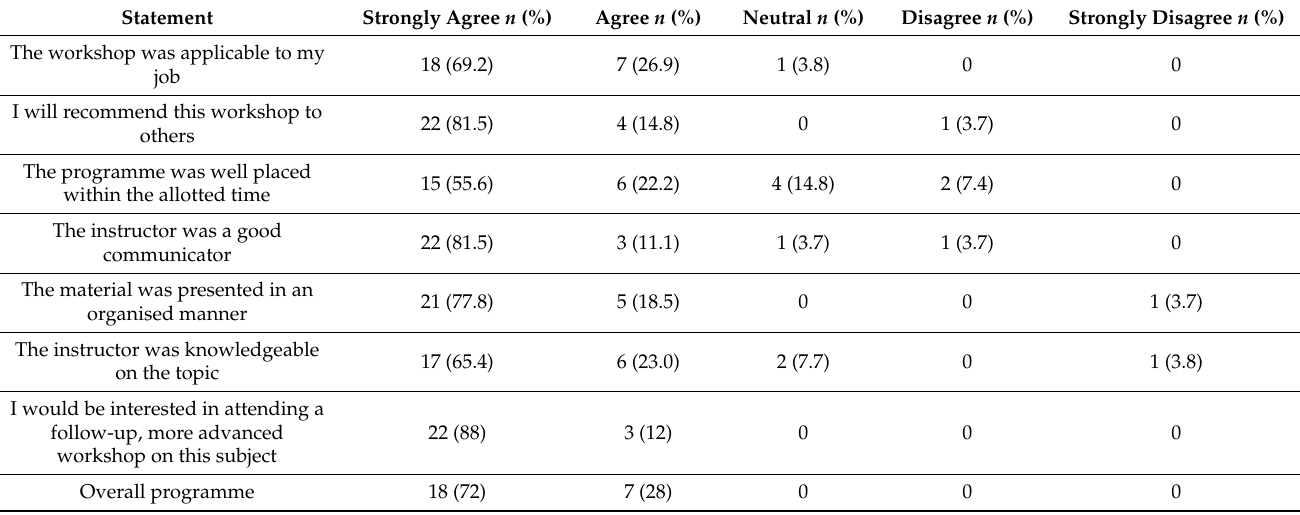
Table 3. Quantitative evaluation of participants’ views of the workshop N =